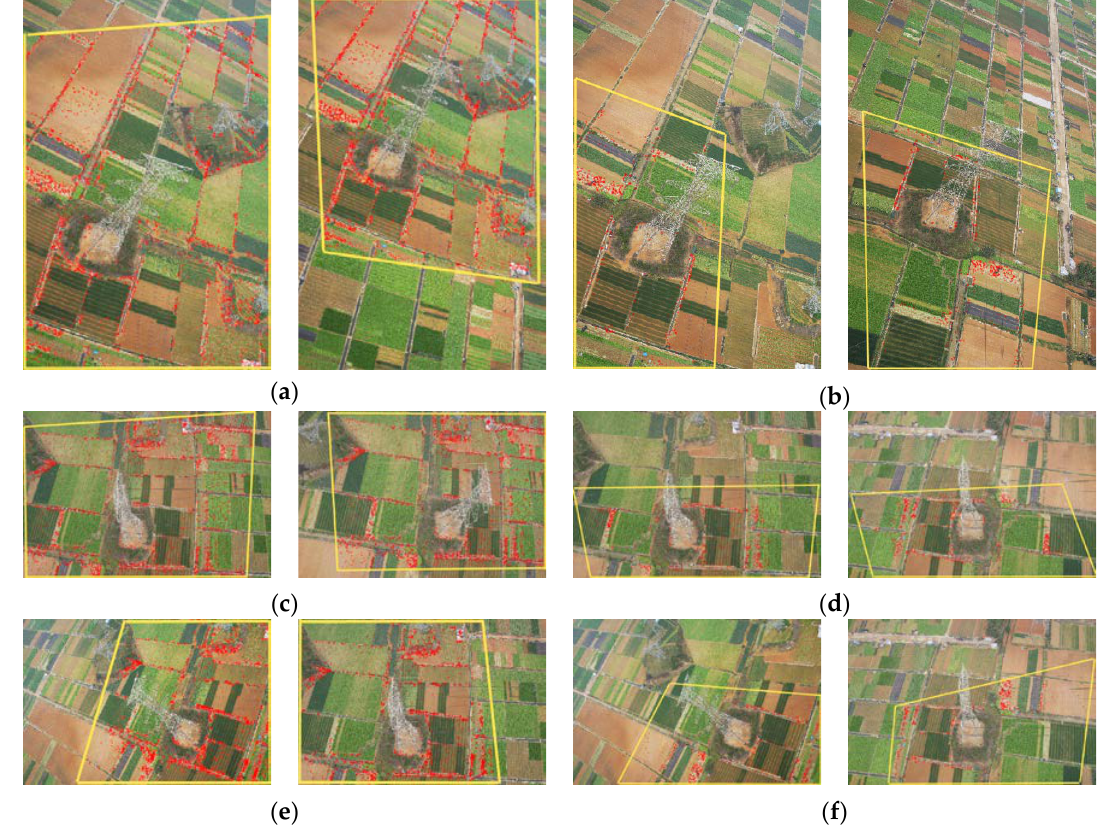
Figure 10. Tie-points extraction for image pairs. F and B stand for front and back cameras, respectively. The yellow quadrangle stands for overlap region. ( a ) Front–front cameras in the same direction with 3497 tie-points; ( b ) front–front cameras in the opposite direction with 496 tie-points; ( c ) back–back cameras in the same direction with 5001 tie-points; ( d ) back–back cameras in the opposite direction with 1162 tie-points; ( e ) front–back cameras in the same direction with 1848 tie-points; and ( f ) front–back cameras in the opposite direction with 852 tie-points.